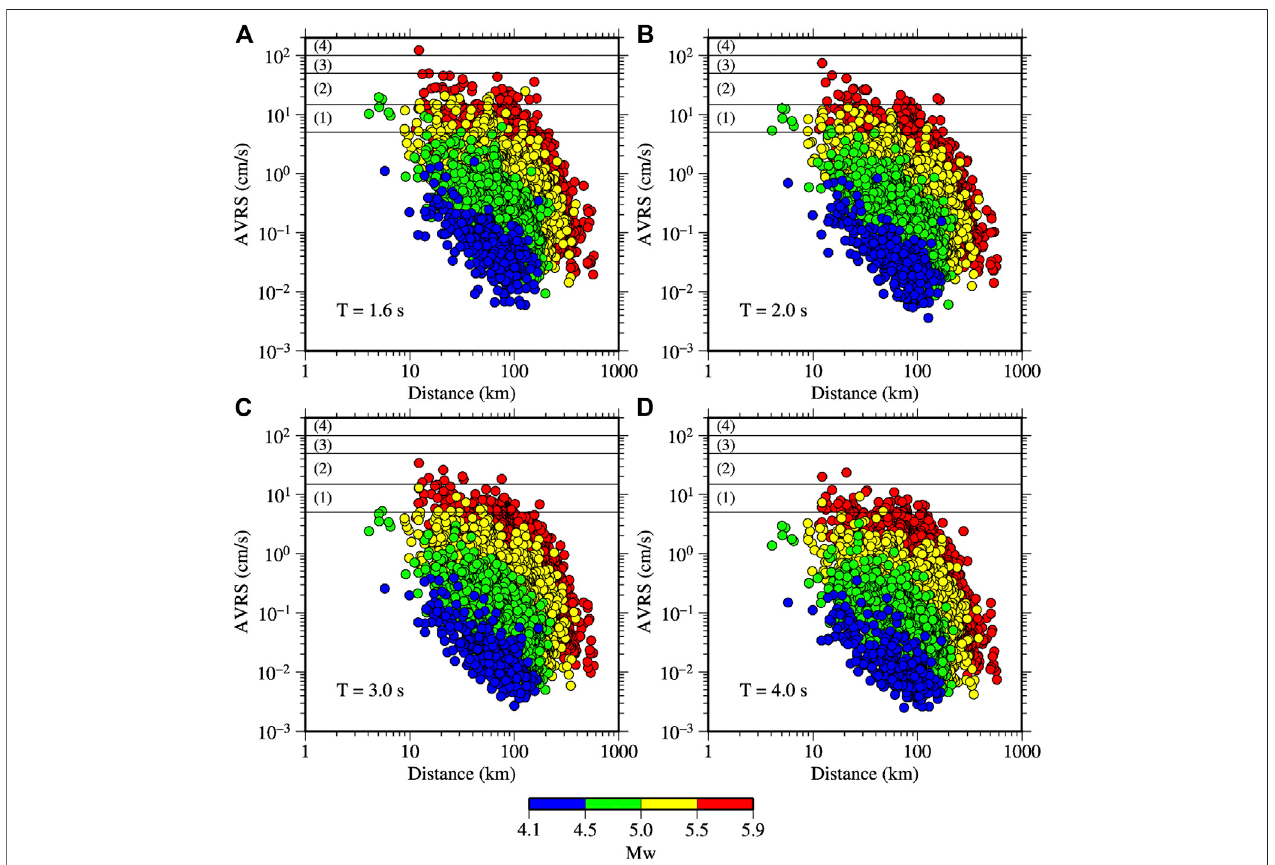
FIGURE8| Absolutevelocityresponsespectra(AVRS)attheperiodsof1.6,2.0,3.0,and4.0splottedagainstthehypocentraldistancein A , B , C , D ,respectively. The horizontal lines across the AVRS of 5, 15, 50, and 100 cm/s mark the threshold values for JMA long-period ground motion intensities of 1, 2, 3, and 4, respectively.